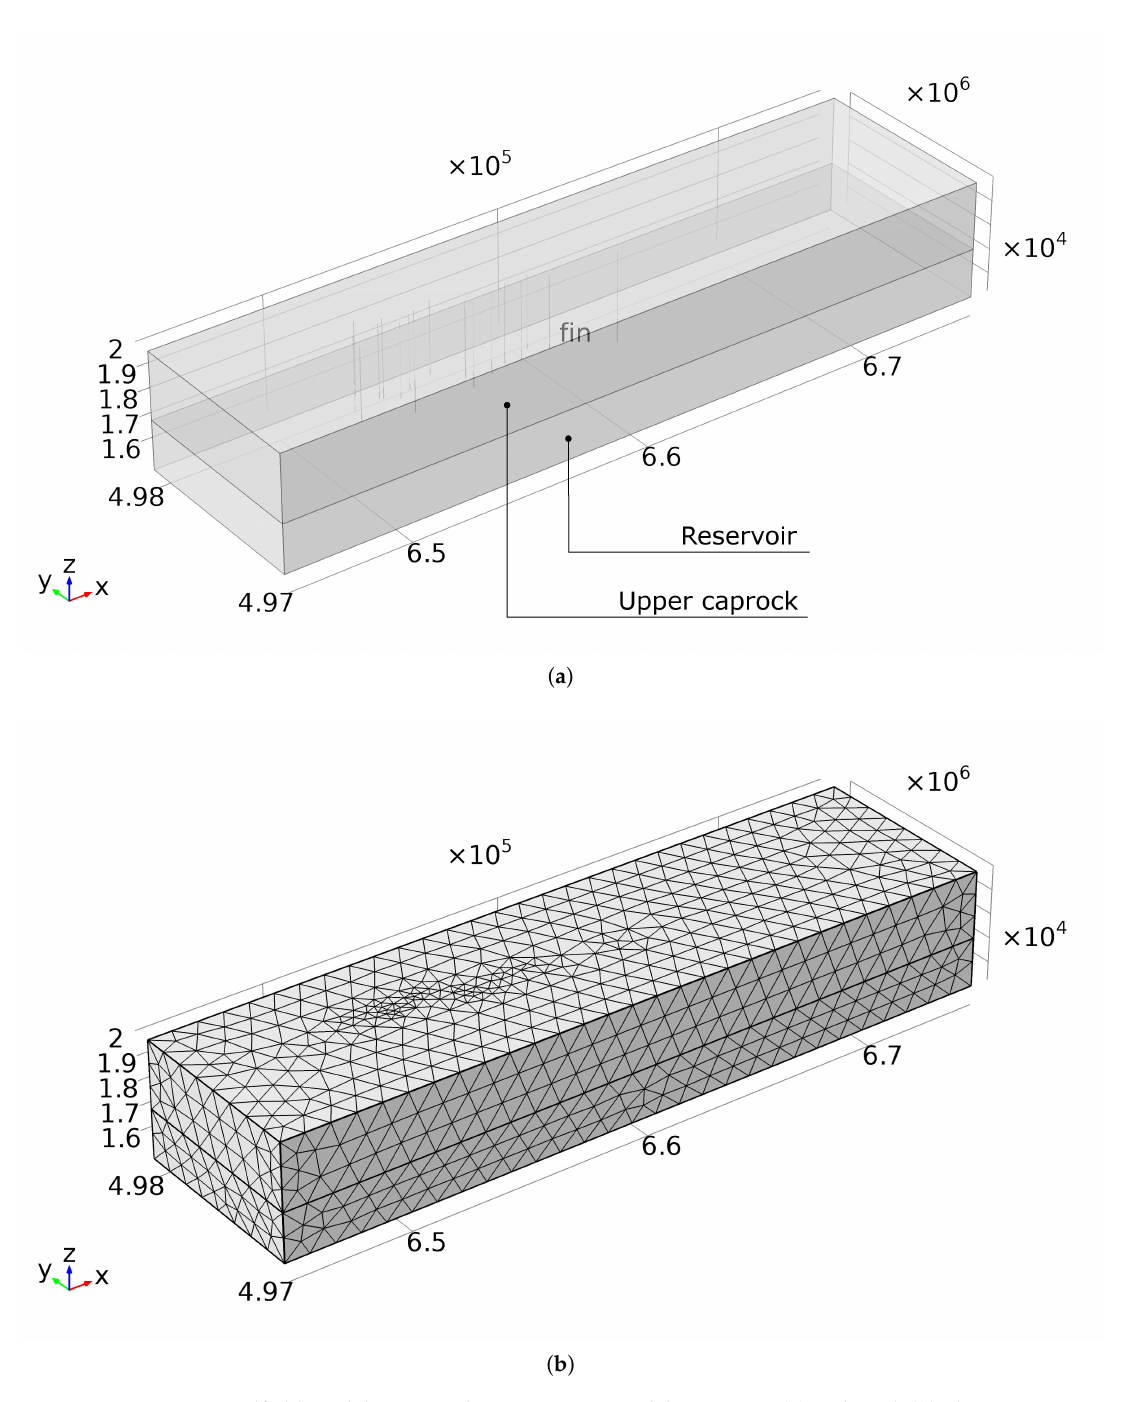
Figure 2. Cavone oilfield modeling—two layer reservoir model: geometry ( a ) and mesh ( b ); dimensions are in